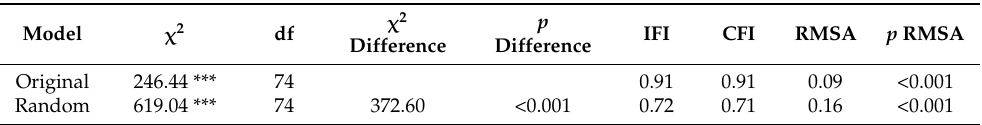
Table 4. Goodness-of-fit of the confirmatory analyses of the original and random models of the english version of the LIRS (14 items)—Study